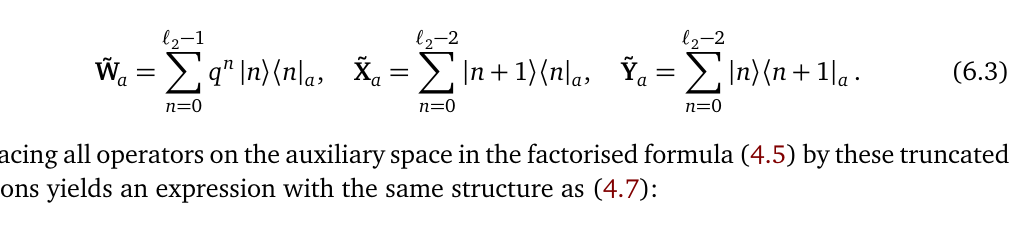
(left) and S + (right) at root of unity with (cid:96) a a